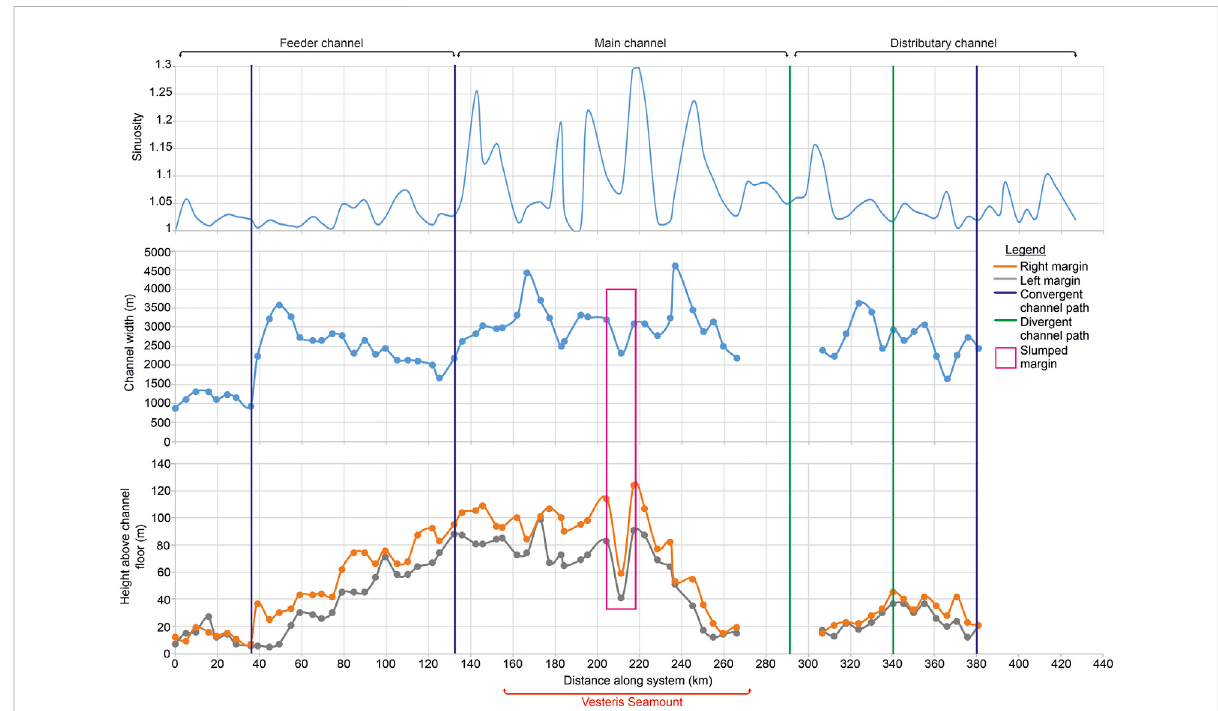
FIGURE 4 Comparison of sinuosity, channel width, channel margin height ( ‘ right and left margin ’ in legend), thalweg depth and pro fi le symmetry for C1. Convergence and divergence of the channel path are represented by purple and green lines, respectively. Missing gaps in channel height and width measurements are through degradation of the channel form in the data, likely related to vertical resolution, although planform expression is still present. Right and left channel margin with respect to fl ow direction. ‘ Slumped margin ’ refers to slumping of the channel